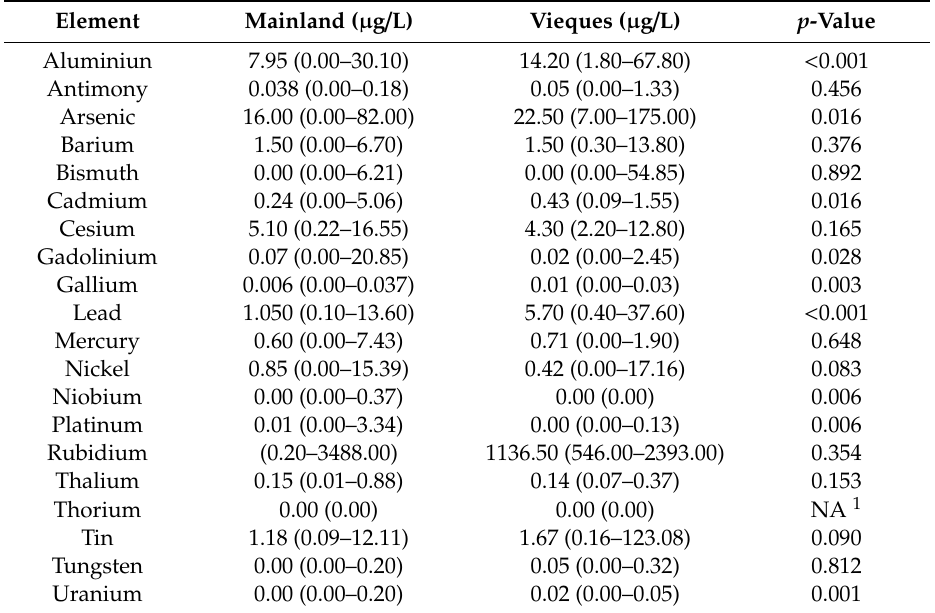
Table 1. Median element concentrations (range) in urine samples from patients in Main Island ( n = 51) and Vieques ( n = 32), Puerto